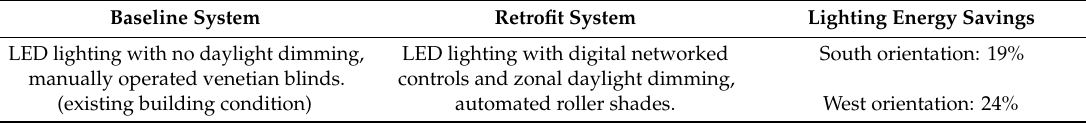
Table 4. Test System 1 characteristics and energy